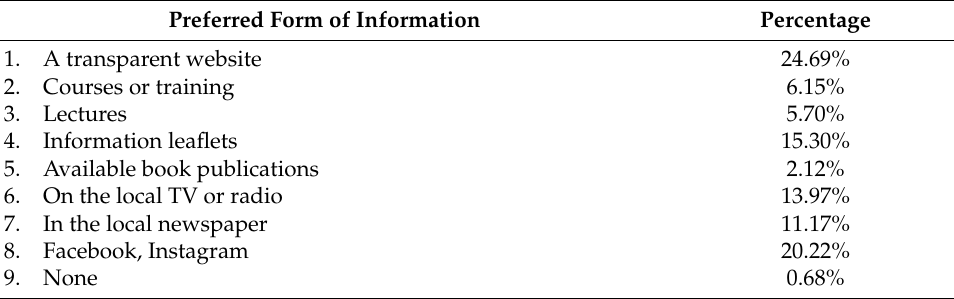
Table 8. Preferred form of information about civil protection and population protection.